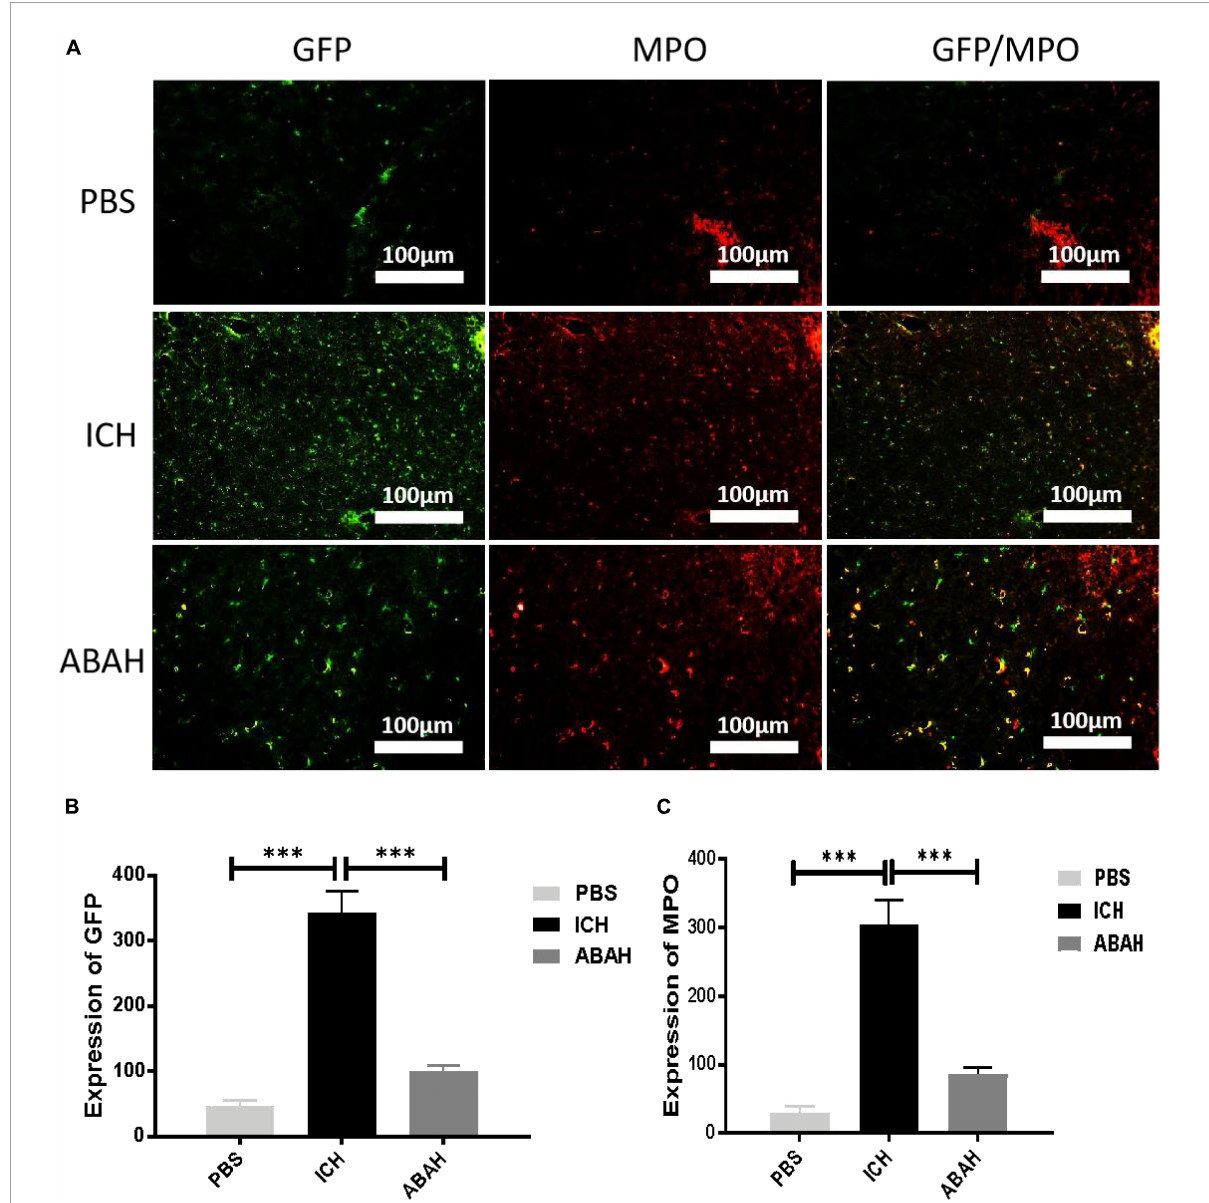
FIGURE5 Inhibition of MPO activity reduces microglial proliferation following ICH. (A) Immunofluorescence double staining was performed in the PBS, ICH, and ABAH groups at 24 h post-injury. The labeled molecules were microglia and MPO; (B) microglia expression (*** P < 0.001, n = 6 in each group); (C) MPO expression (*** P < 0.001, n = 6 in each